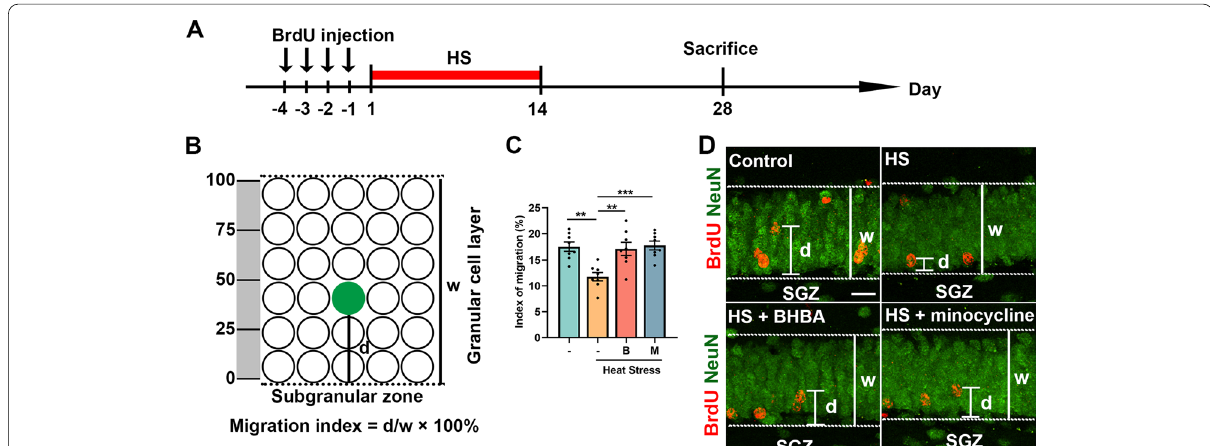
Fig. 5 BHBA promotes the migration of newborn neurons in the hippocampus of heat stress-injured mice. A Protocol for testing the effect of heat stress on neuronal migration in the dentate gyrus. B Schematic representation of the calculation method of the index of neuronal migration through the GCL. The migration index was calculated using the formula, index of migration between the center of BrdU + NeuN + cells and the SGZ, and w represents the width of GCL. C The graph displayed the index of migration. The index of migration was lower in mice with heat stress treatment, which was rescued by BHBA or minocycline treatment. D Representative confocal maximal projection images depicting the migration pattern of BrdU + NeuN + cells through the GCL. Scale bar performed using one-way ANOVA with Tukey’s post-test. Data are represented as mean HS, heat stress; M, minocycline; SGZ, subgranular